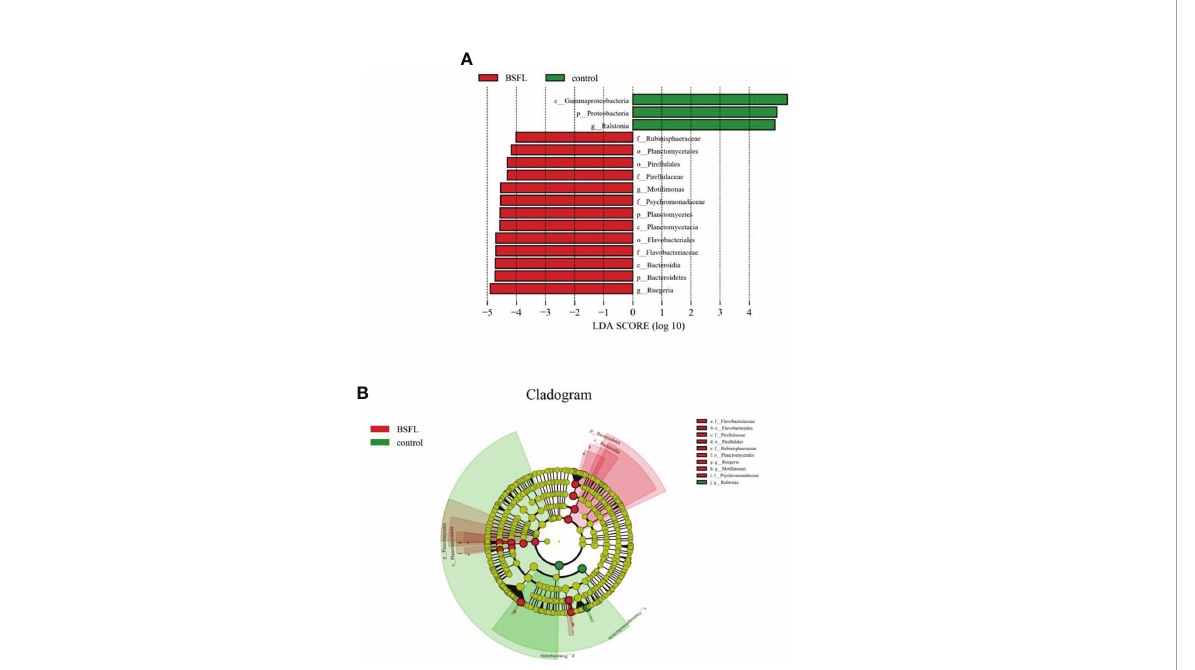
FIGURE 7 The LDA effects size (LEfSe) analysis of bacterial taxa between the control and fresh BSFL-containing groups. (A) Bar chart displays LDA scores of the control and fresh BSFL-containing groups. The LDA scores represented the differencein relative abundance with exponent fold change of 10 between two treatments. Signi fi cant differences are de fi ned as P < 0.05 and LDA score >0.04. (B) Cladogram displays signi fi cantly enriched bacterial taxa (from the phylum to the genus